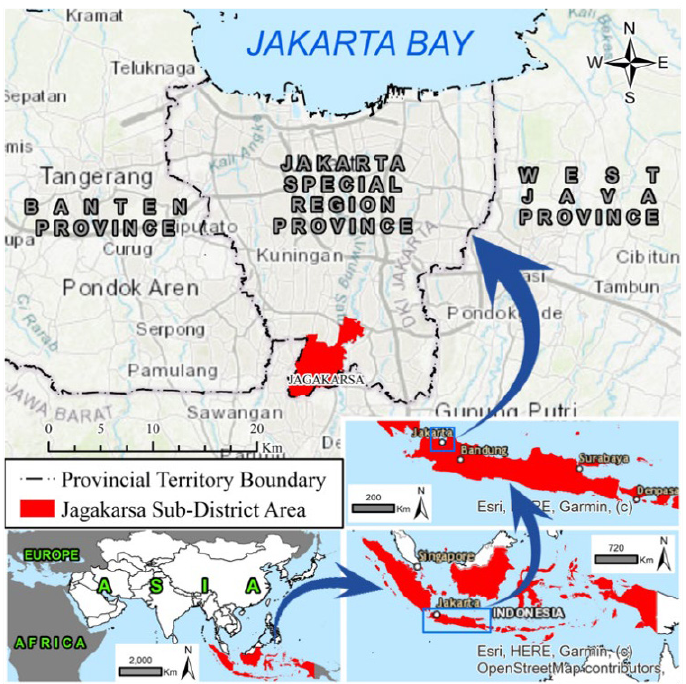
Fig. 1: Geographic location of the study area in South Jakarta, Indonesia